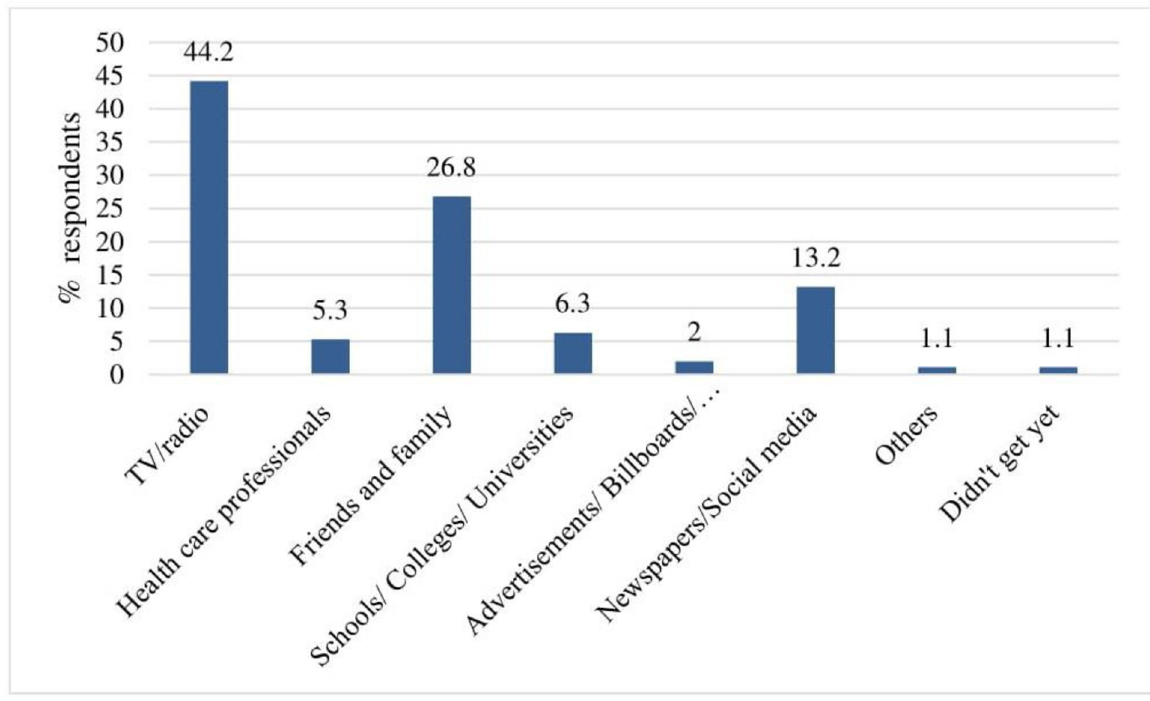
Fig 3. Source of information in dengue fever in Bangladesh.